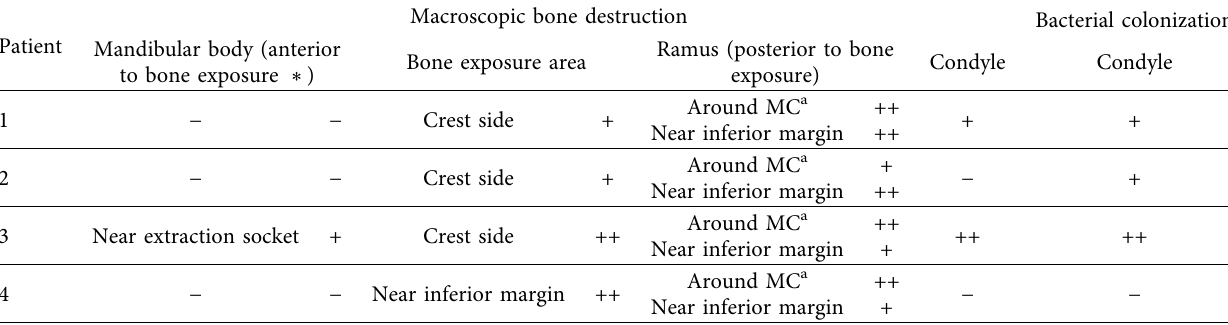
Table 2: Extents of macroscopic bone destruction and bacterial colonization within the condyle in hemimandibulectomy specimens.